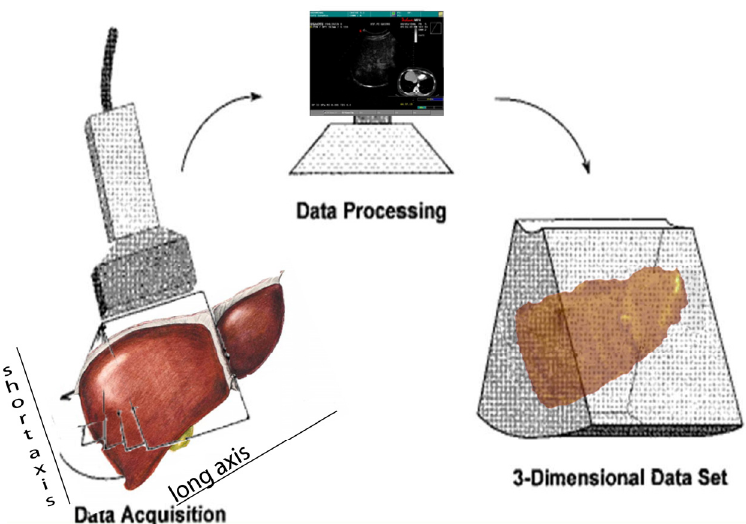
Figure 2. Draft of 3-D reconstruction: LEFT: Bidimensional continuous scanning of the liver evaluating its short axis through its long axis; the planes captured along the liver are rendered in a 3-dimensional reconstruction using software within the Navigator